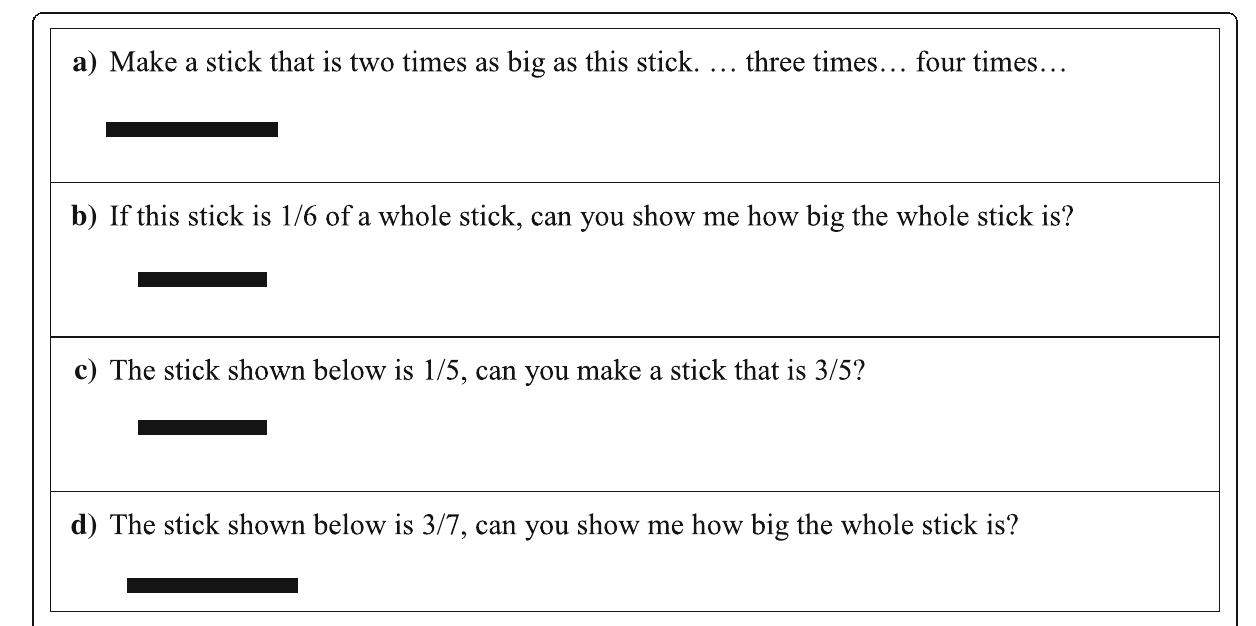
Fig. 7 a – d Examples of tasks for transitioning children from a PWS to MSUF to